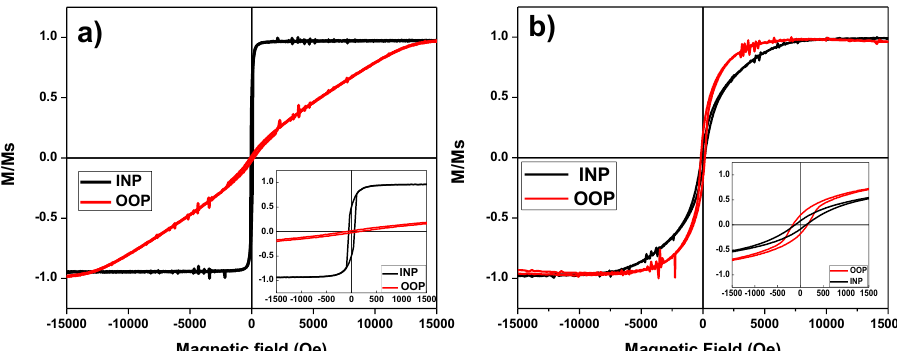
Figure 5. ( a ) Vibrating Sample Magnetometer In Plane (VSM INP) and Out Of Plane (OOP) hysteresis loops for the continuous Dy 13 Fe 87 thin film with 30 nm thickness. The inset shows the low field scale of INP and OOP hysteresis loops; ( b ) INP and OOP VSM hysteresis loops for Dy 13 Fe 87 antidot film with 30 nm thickness, Dint = 105 nm and d = 45 nm. The inset shows the magnification of the low field region.